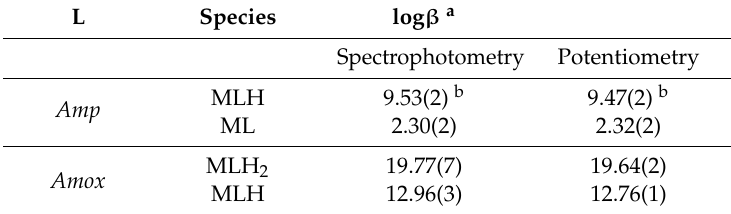
Table 2. Comparison between experimental formation constant values of Mn 2+ - Amp species obtained by spectrophotometry and potentiometry at t = 25 °C and I = 0.15 mol L − 1. L Species log β a Spectrophotometry Potentiometry